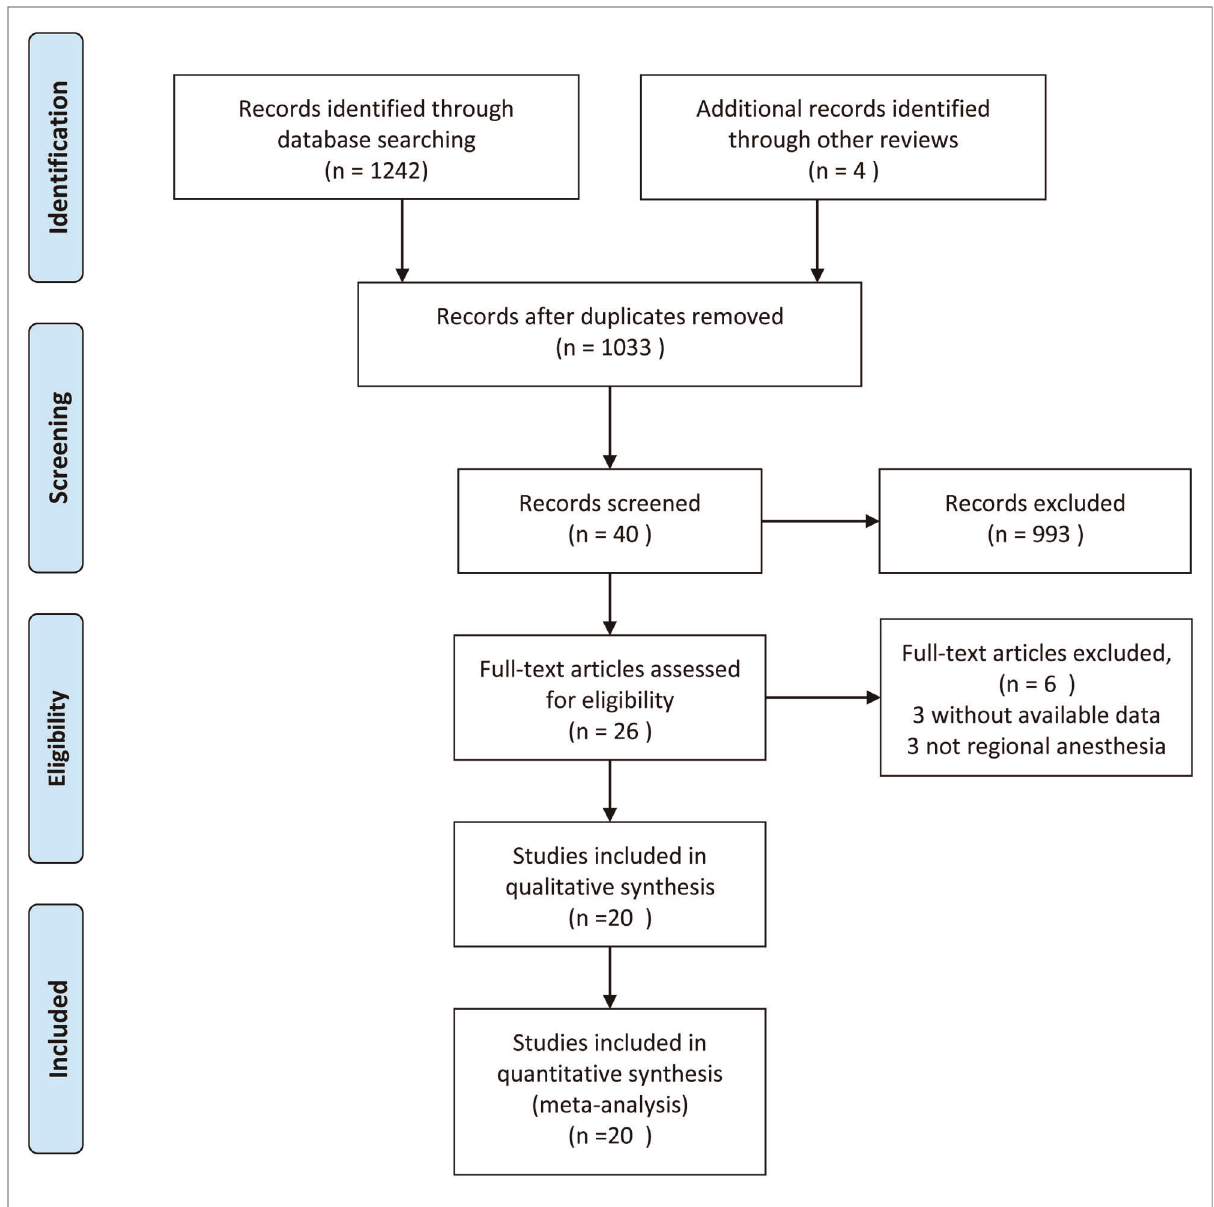
FIGURE 1 PRISMA fl ow chart for literature